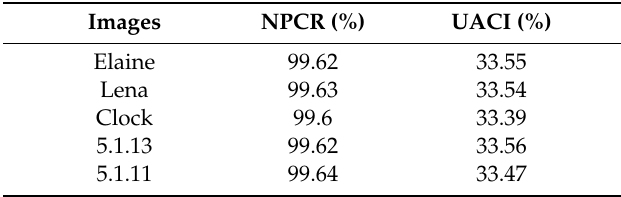
Table 4. NPCR and UACI values of cipher